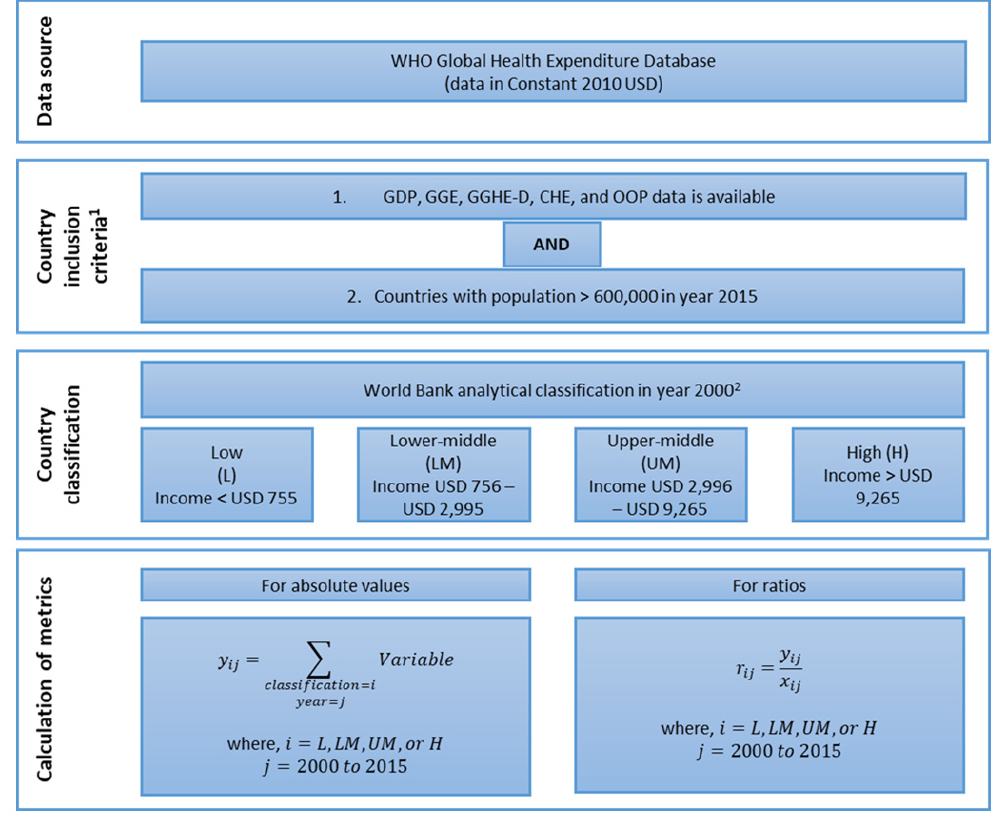
Figure 2. Flow chart showing data sources, country inclusion criteria, country classification by income, and calculation of key metrics. GDP, gross domestic product; GGE, general government expenditure; GGHE-D, domestic general government expenditure on health; CHE, current health expenditure; OOP, out-of-pocket expenditure.